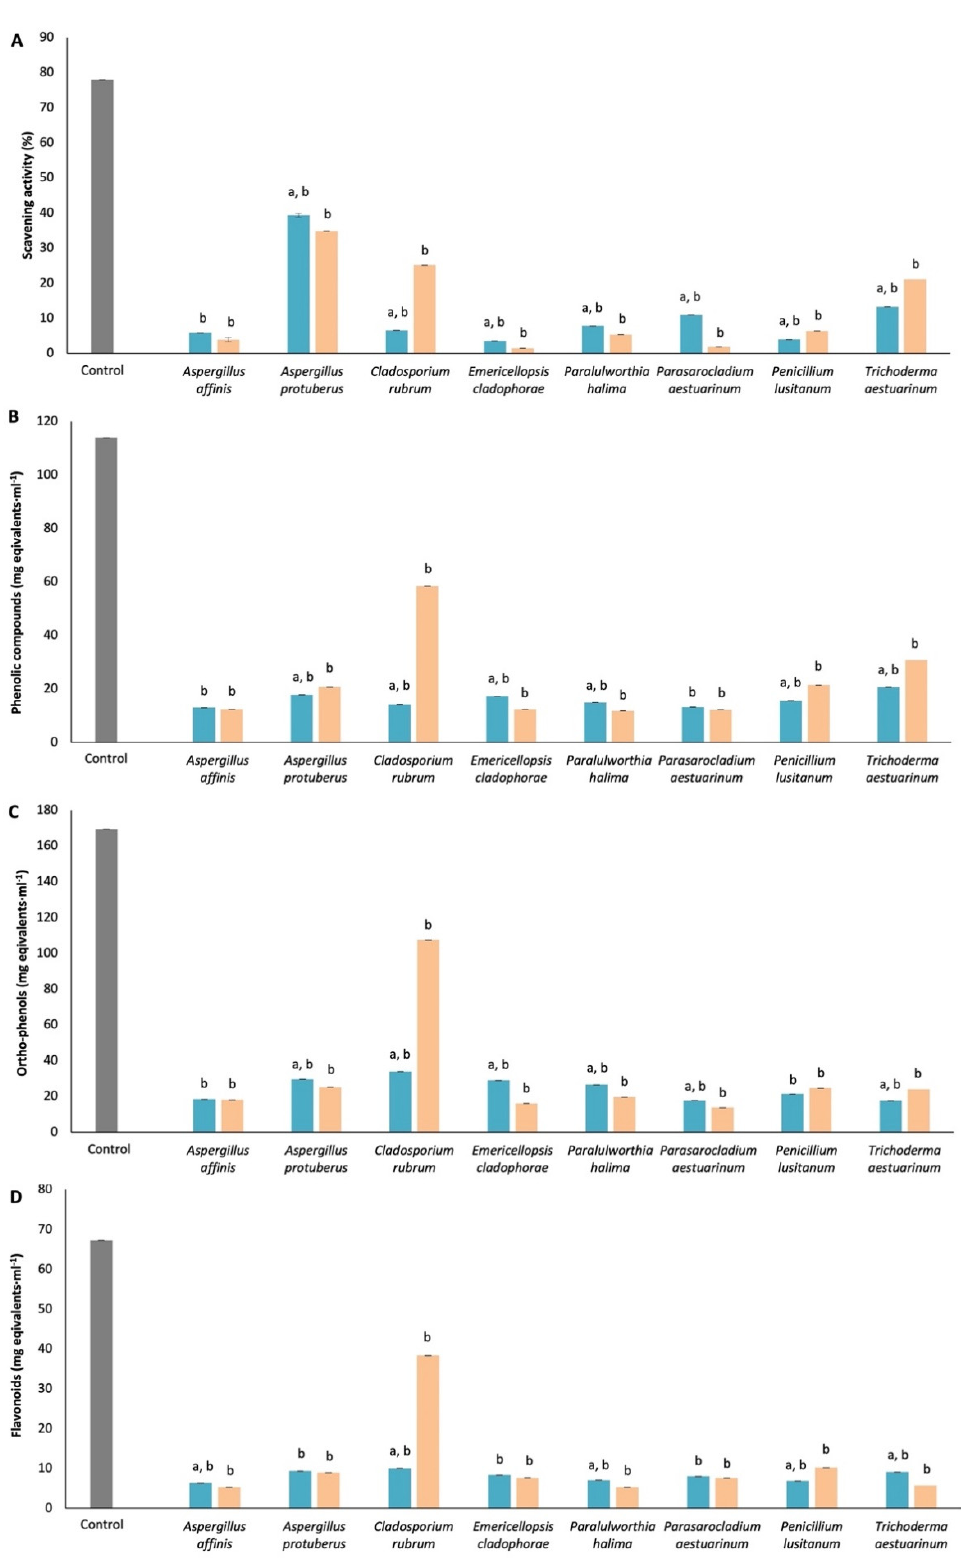
Figure 5. Antioxidant activity of fungal mycelium with (blue) and without 3% sea salt (orange) using methanolic extracts. ( A ) Percentage of DPPH scavenging activity; ( B ) phenolic compounds’ content; ( C ) ortho-phenols’ content; ( D ) flavonoids’ content. Data are presented as average ( n = 5) ± standard deviation. (a) indicates a significantly different t -test, p < 0.05, in relation to the correspondent non-saline sample, and (b) indicates a significantly different t -test, p < 0.05, in relation to the control.